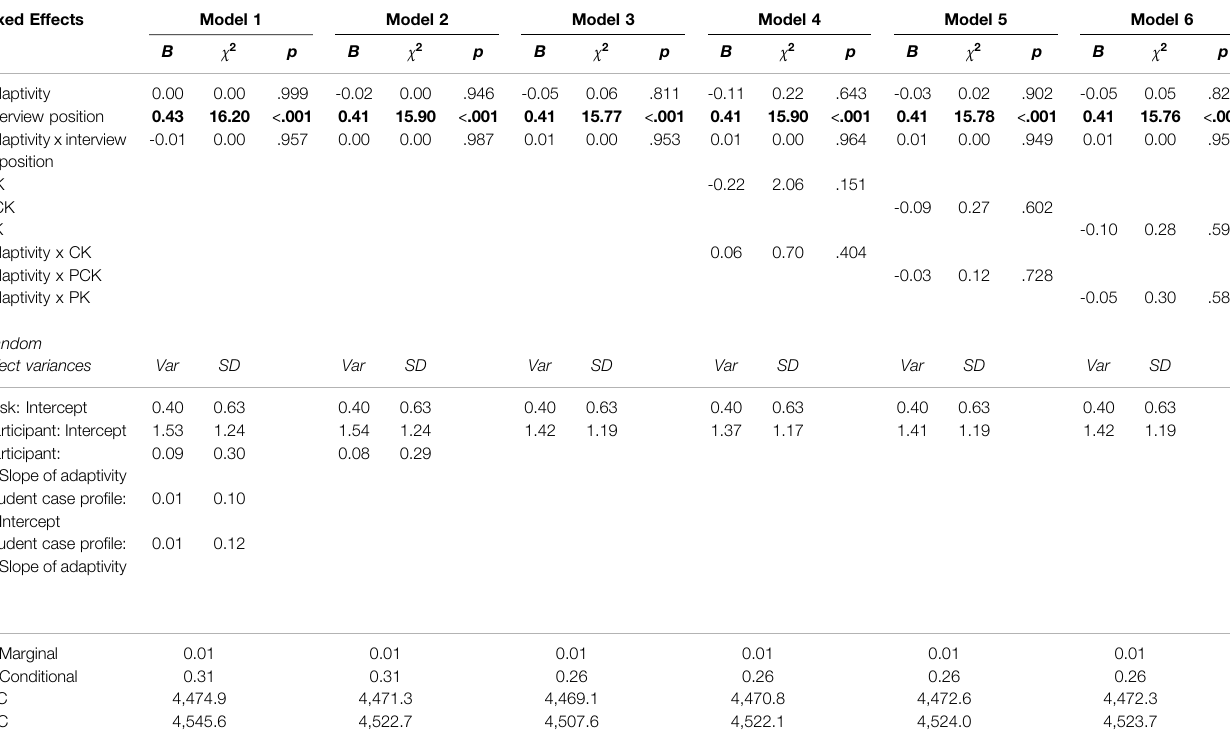
TABLE 5 | Different GLMM for analyzing the adaptive use of diagnostic task potential. Fixed